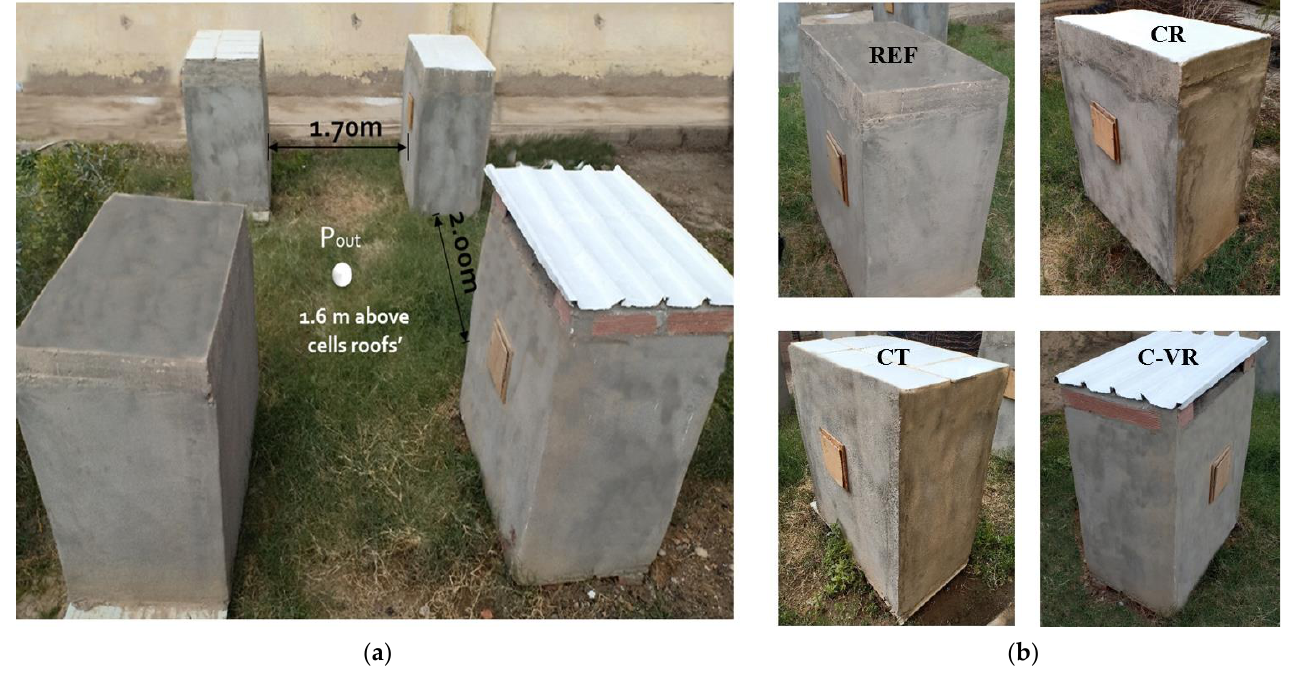
Figure 3. ( a ) General view of the four test cells showing their arrangement. ( b ) The studied roofing techniques after their application on the test cells, namely from upper left to right and from top to bottom: reference test cell with base-case roof (REF), test cell with cool reflective white paint (CR,) test cell with white ceramic tiles (CT) and test cell with a cool-ventilated roof